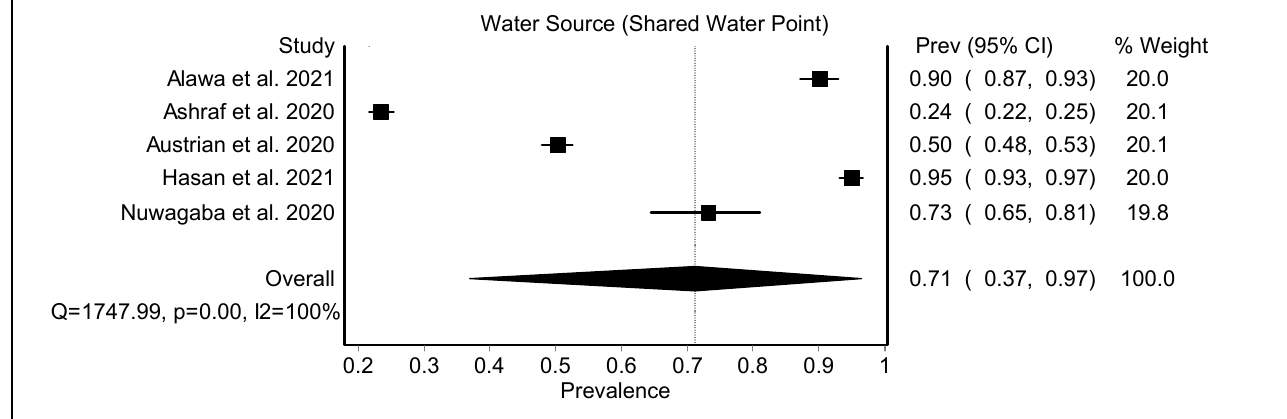
Water Source (Shared Water Point)